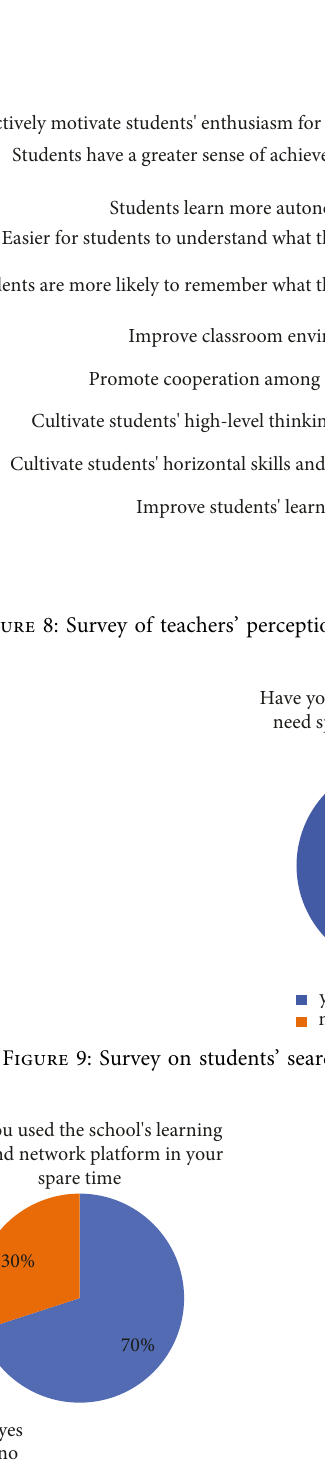
Figure 10: Survey on students’ learning spaces and online plat- forms after school hours. Figure 11: Survey of students’ opinions on whether online in- formation learning is